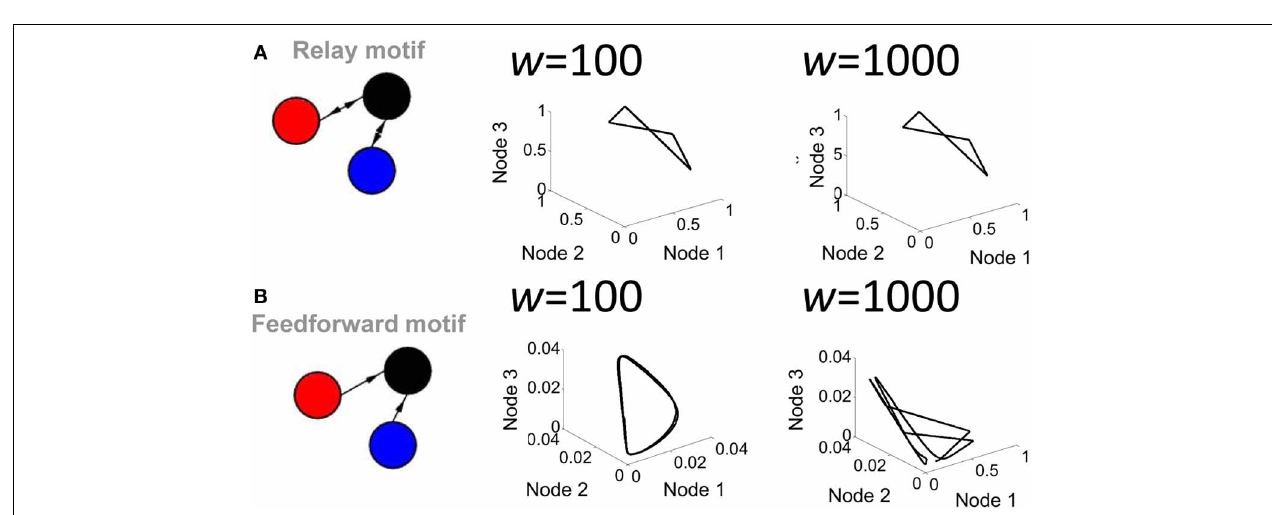
FIGURE 4 | Influence of connection strength on the activity of a relay network. (A) Phase-plane plot of activity in a relay network where all connections had low ( w = 100) or high ( w = 1000) values. (B) Same as (A) but with a strictly feedforward network.